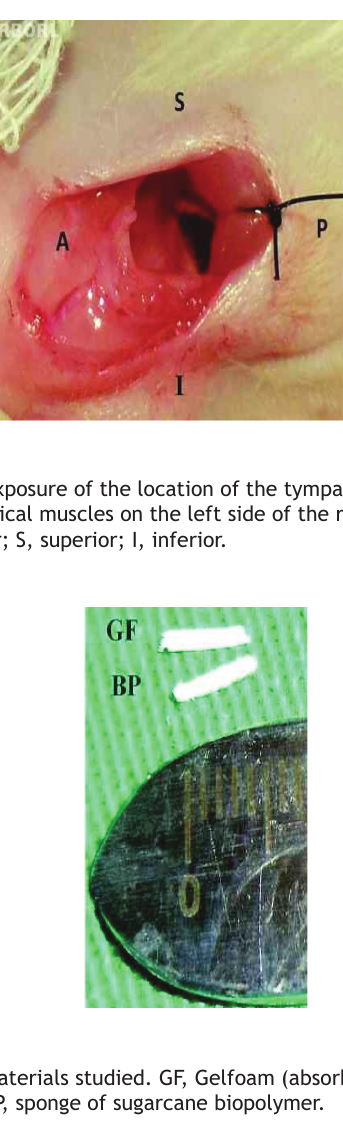
Figure 1 Wistar rat in lateral decubitus. Surgical incision in the retroauricular region of the left ear. A, anterior; P, posterior.